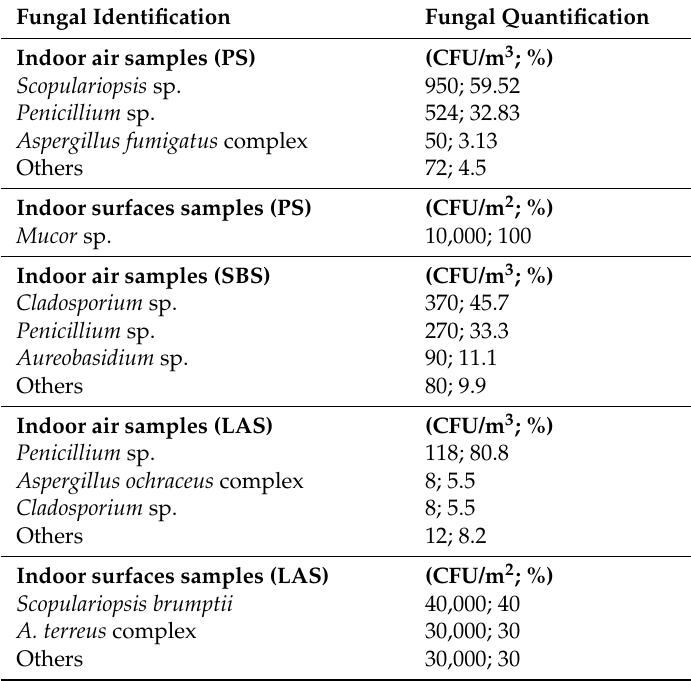
Table 4. Most common fungi isolated in the three